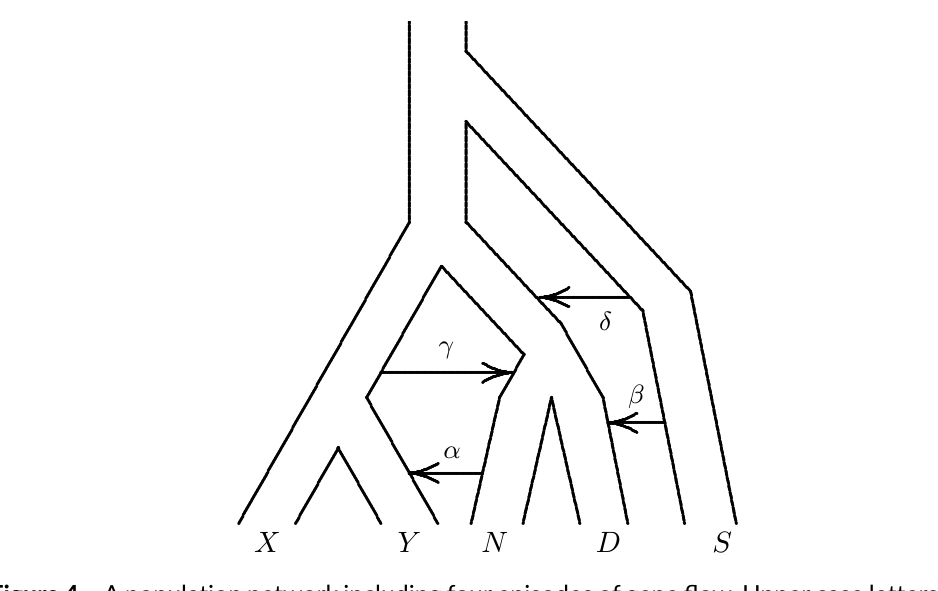
Figure 4 – A population network including four episodes of gene flow. Upper case letters ( X , Y , N , D , and S ) represent populations (Africa, Europe, Neanderthal, Denisovan, and superarchaic). Greek letters label episodes of